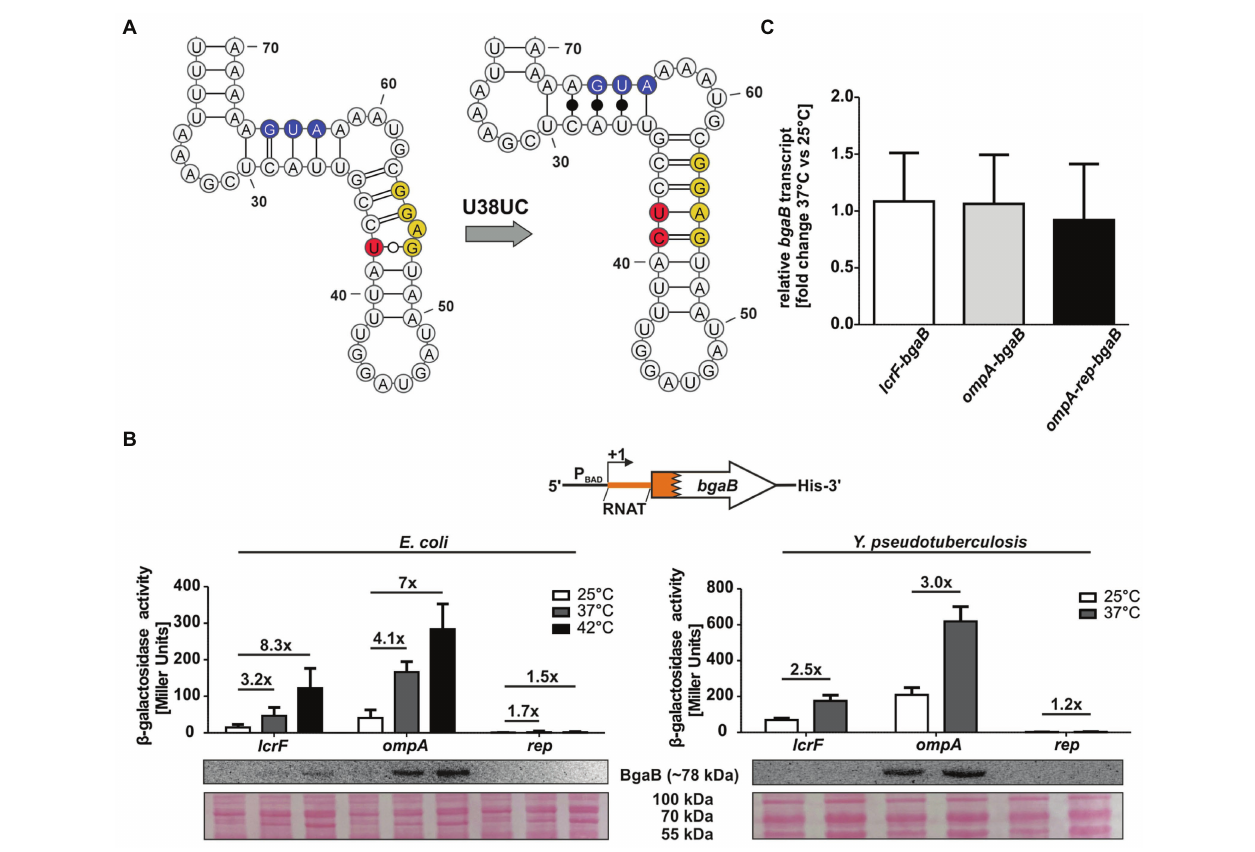
FIGURE 2 | Mutation of the anti-SD sequence locks the RNAT in a closed conformation. (A) PARS-derived secondary structure of the ompA RNAT stem and the predicted stabilized structure at 25 ° C. The potential SD sequence is highlighted in yellow, the mutation site of the anti-SD sequence in red and the AUG in blue. (B) Translational control was measured by bgaB fusions. A schematic representation of the reporter gene fusion is displayed. The ompA RNAT was translationally fused to bgaB under control of the P BAD promotor. Additionally, a point mutation (U38UC) was introduced to stabilize the RNAT (rep). As a control, the lcrF RNAT fusion was used. The fusion plasmids were introduced into E. coli and Y. pseudotuberculosis YPIII cells and grown to an OD 600 of 0.5 at 25 ° C. Subsequently, transcription was induced by the addition of 0.01% for E. coli or 0.1% for Y. pseudotuberculosis L-arabinose and the cultures were split and transferred into pre- warmed flask at 25 and 37 ° C, respectively. After 30 min of incubation, samples were taken for β -galactosidase assays, Western blot analysis, and qRT-PCR. Experiments were carried out in biological triplicates. Mean and corresponding standard deviations are shown. Western blot membranes were stained with Ponceau S as a loading control. One representative Western blot is shown. Analysis was carried out in biological triplicates. (C) Comparison of bgaB transcript amount between 37 and 25 ° C by qRT-PCR of exponentially grown YPIII cells harboring the ompA RNAT- bgaB fusion plasmids at 25 and 37 ° C, respectively. For